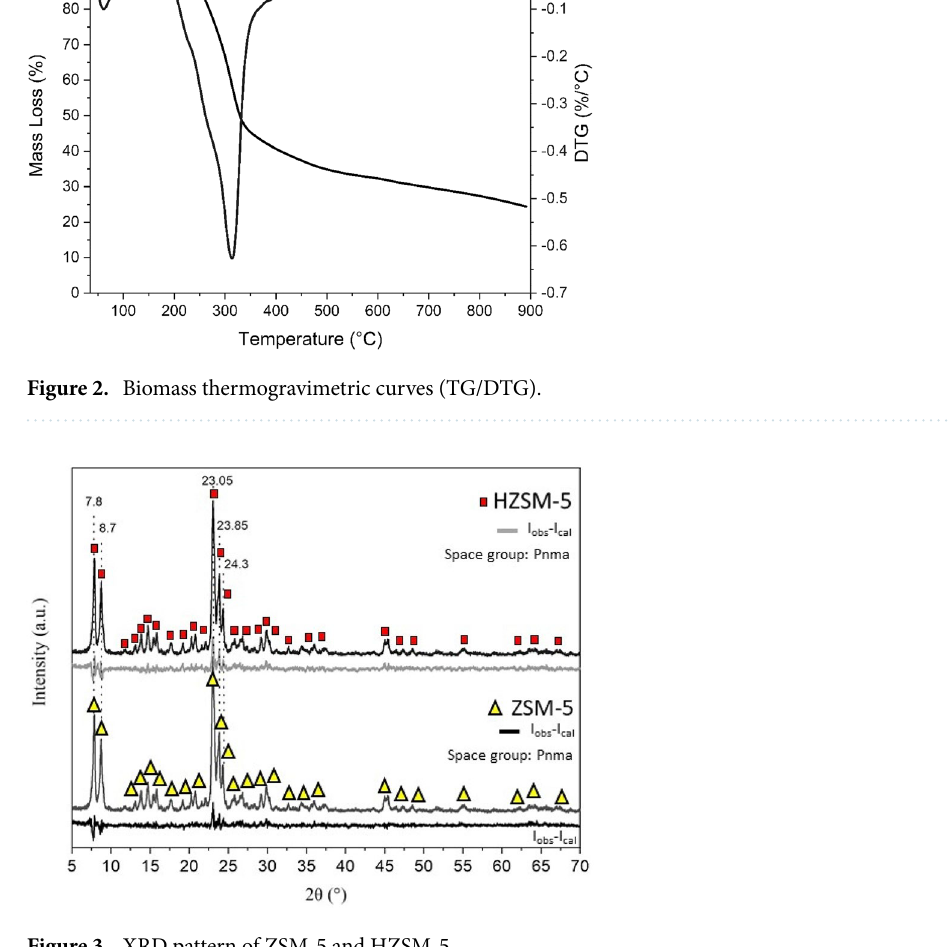
Figure 3. XRD pattern of ZSM-5 and